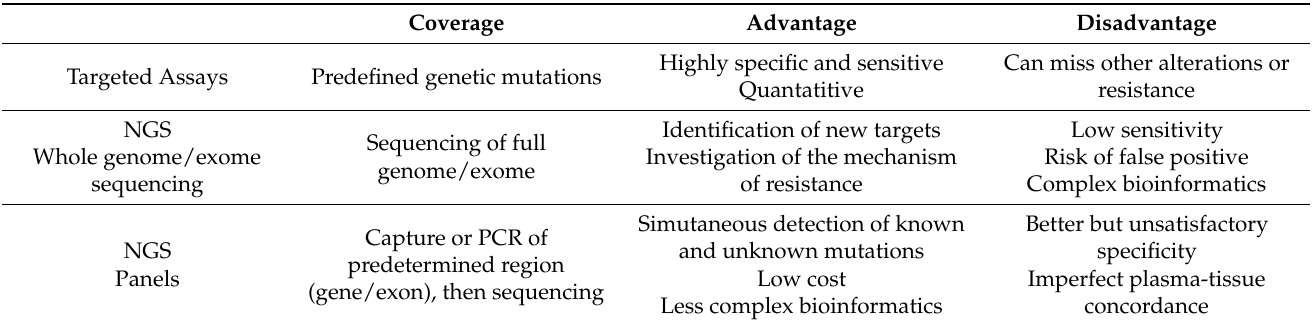
Table 1. Comparison of ctDNA analysis